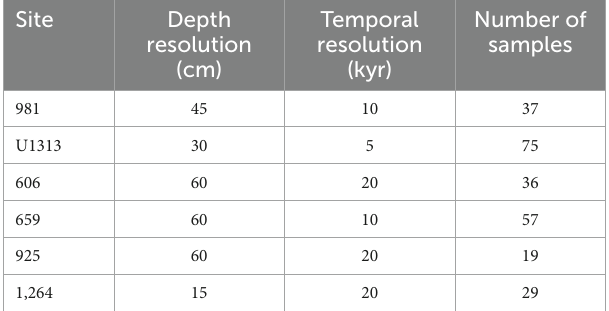
TABLE 1 Sampling resolution and number of samples analyzed per